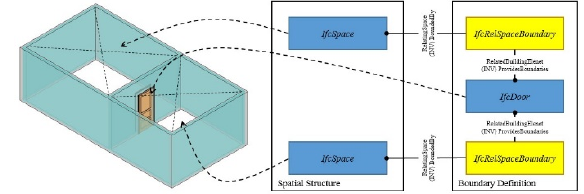
Figure 3. IfcRelSpaceBoundary : the case of physical space boundary (modified from buildingSMART, 2007) 2.3 Integrating IndoorGML Information